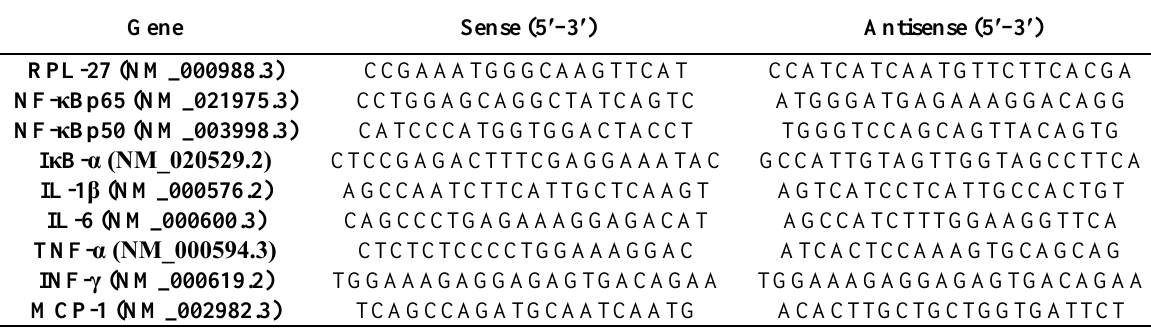
Table 1. Primer sequences used in the qPCR